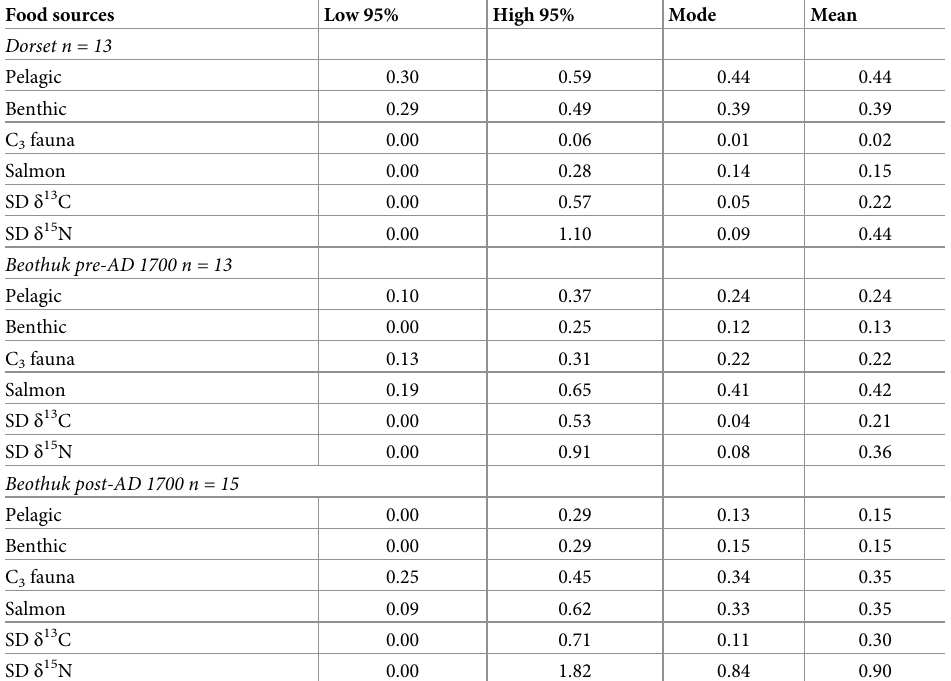
Table 3. Results of the SIAR model, including 95% credibility intervals, mode and median estimates. Food sources Low 95% High 95% Mode Mean